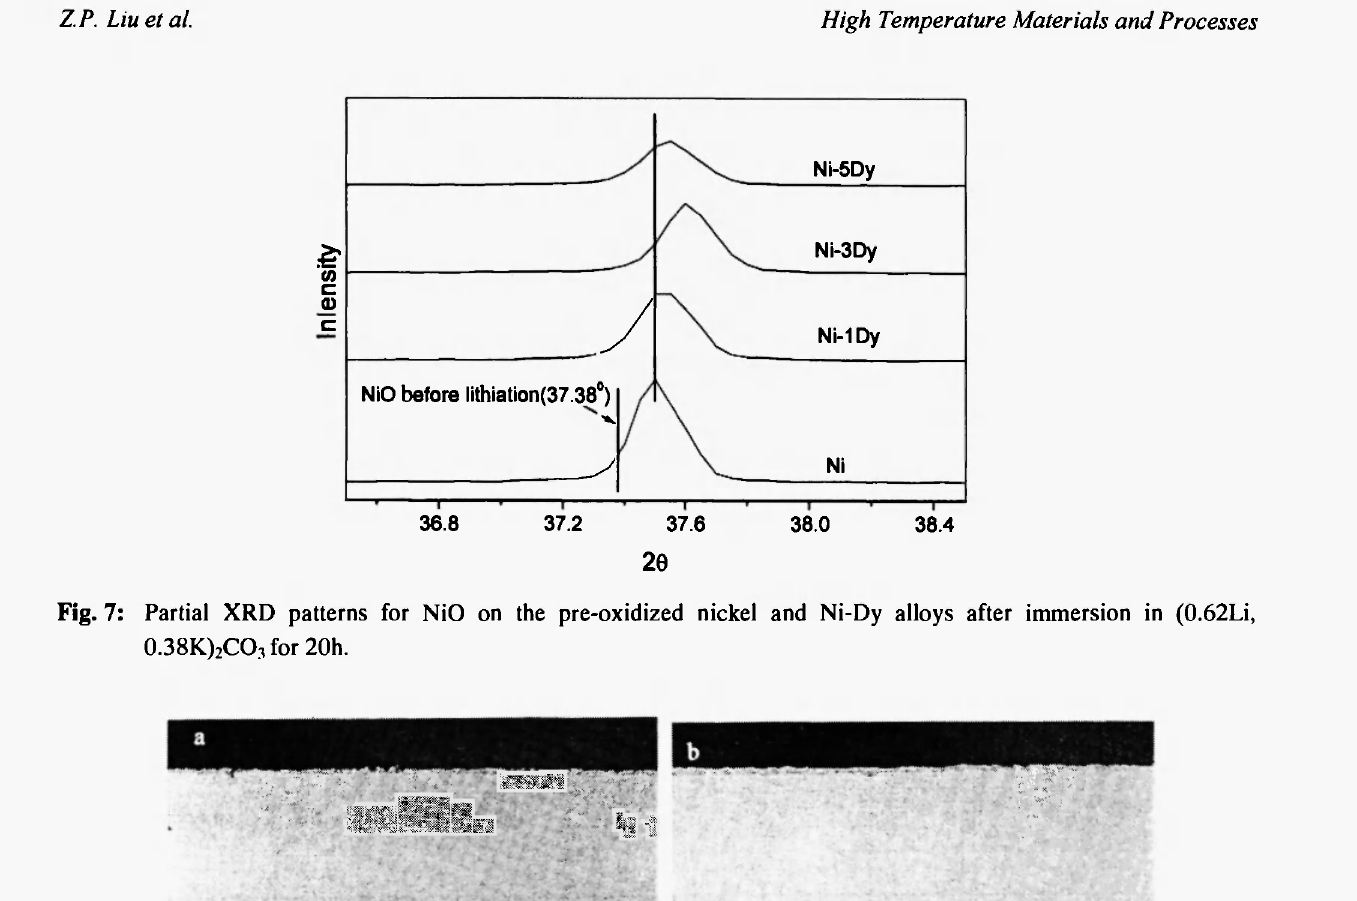
Fig. 7: Partial XRD patterns for NiO on the pre-oxidized nickel and Ni-Dy alloys after immersion in (0.62Li, 0.38K) 2 C0 3 for20h.